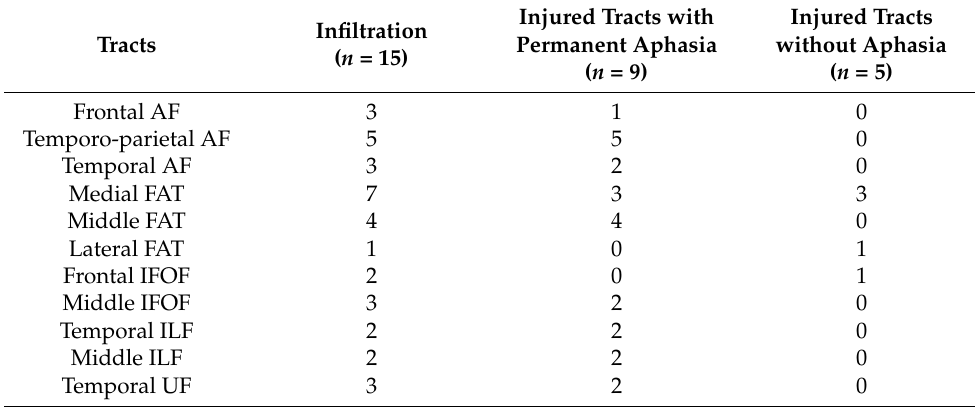
Table 2. Infiltered and injured tracts.